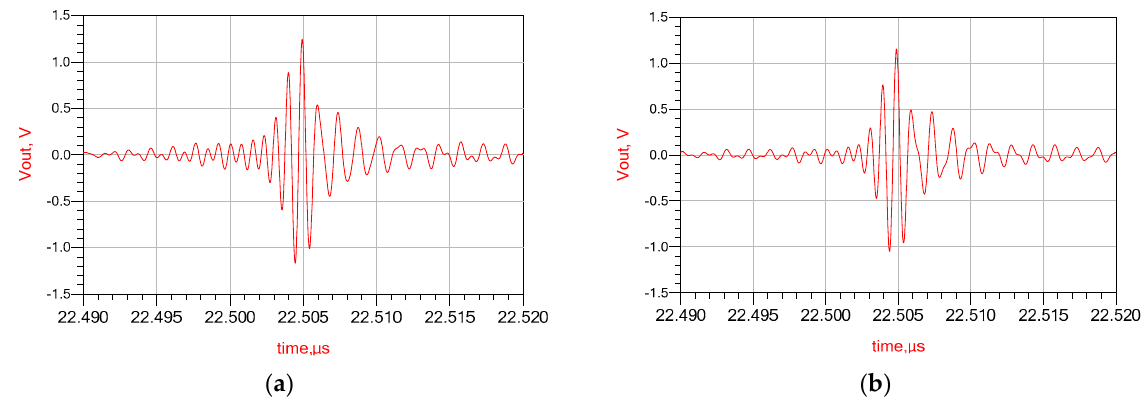
Figure 8. Single pulse appearing at 22.5 µs compressed from the input frequency of 1.85 GHz. ( a ) is the pulse compressed by the classical two-channel CTS structure; ( b ) is the pulse compressed by the FCS M-C arrangement.